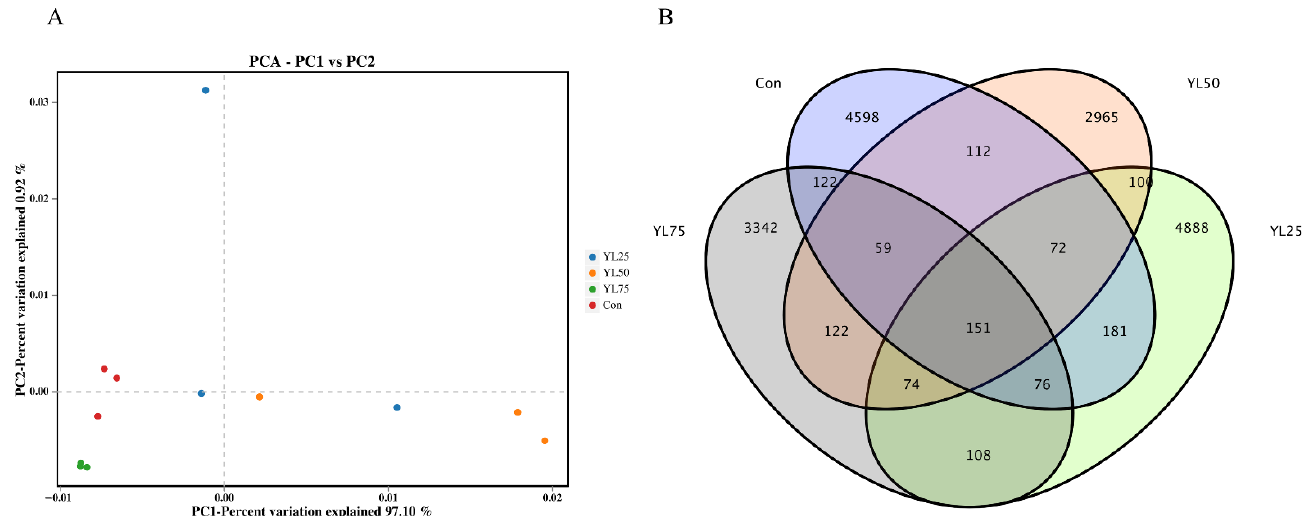
Figure 3. The PCA and Venn diagram of intestinal microbiota of largemouth bass fed with four experimental diets. ( A ) The principal component analysis of the control and YL treatments. Red splashes represent control treatment, blue splashes represent YL25 treatment, orange splashes represent YL50 treatment, green splashes represent YL75 treatment. ( B ) The Venn diagram showing out numbers. Con was the control diet. In the other three diets, 25%, 50%, 75% of the fish meal was replaced with YL. The diets were named YL25, YL50, and YL75, respectively.